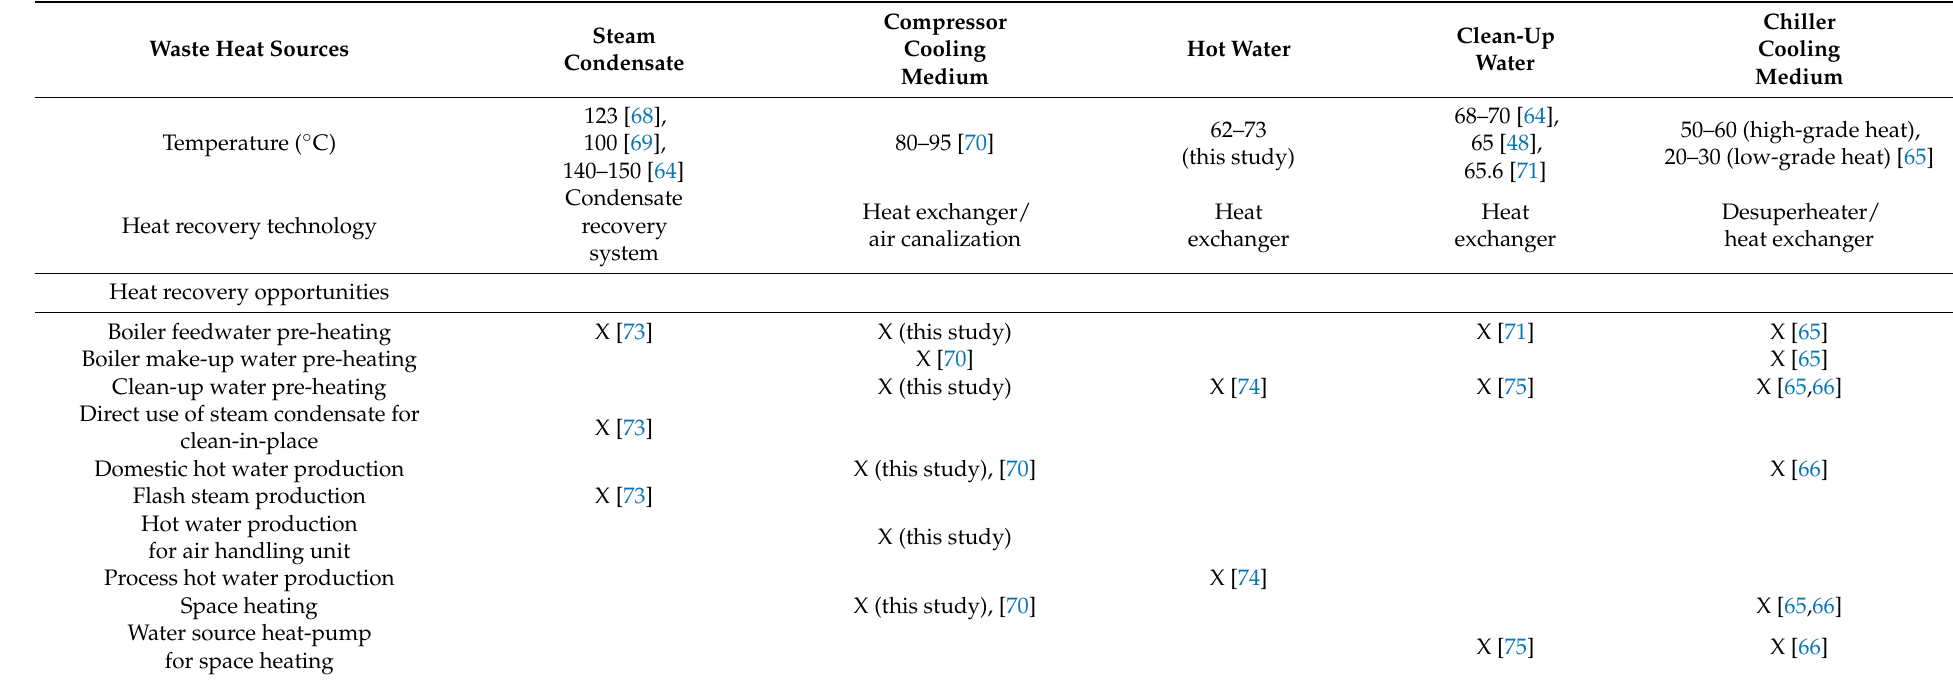
Table A6. Scheme providing the characterization of waste heat sources from butter production and the identification of possible heat